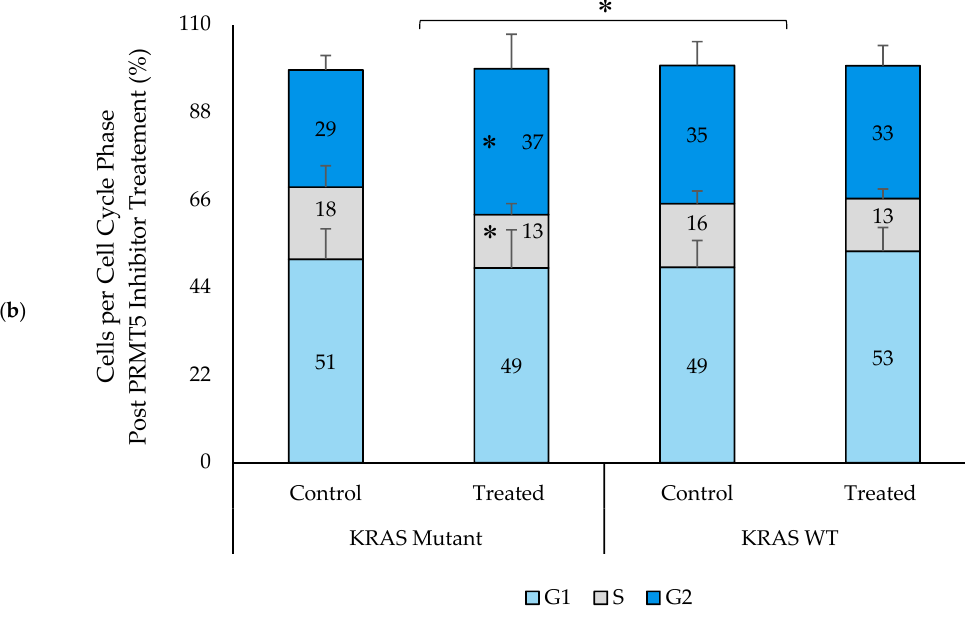
Figure 6. PRMT5 inhibitor treatment is shown to result in a significant G 2 phase cell cycle arrest in the KRAS mutant CRC cells by cell cycle analysis. ( a ) Flow cytometry dot plots displaying cell cycle assay results; ( b ) Quantified cell cycle assay results displaying that PRMT5 inhibitor treatment showed an 8.6% ( p < 0.005) greater increase in G 2 phase cells, as well as 6.2% ( p < 0.05) and 2.3% ( p < 0.05) greater decreases in G 1 and S phase cells respectively after 60 h of 10 μ M PRMT5 inhibitor treatment in the KRAS mutant CRC cells when compared to the KRAS WT CRC cells. Data are expressed as means + SD from four independent experiments using four CRC cell lines (2 KRAS mutant, 2 KRAS WT). Data for the individual cell lines can be seen in Figures S2 and S3. * represents p < 0.05.